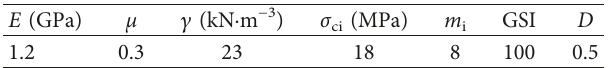
Figure 11: Laboratory loading test (a) and numerical simulation (b). Table 1: Basic material